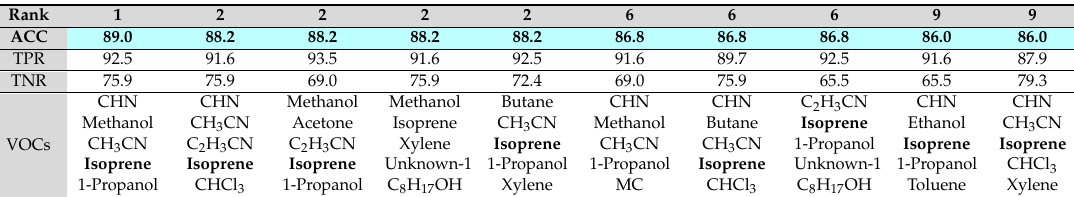
Table 2. Top 10 VOC combinations sorted by ACC (%) (5 VOCs were trained, MC = methylcyclohexane; boldface: most frequent VOC).